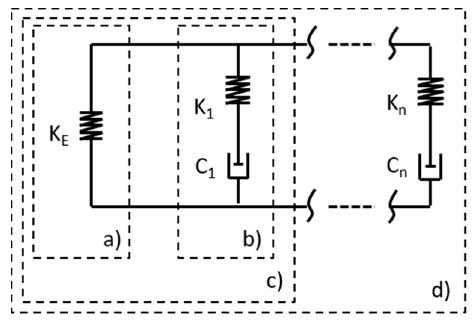
Figure 4 . Most common representations of viscoelastic material. ( a ) Ideal elastic material (Hooke’s representation); ( b ) Combination of restoring and damping force (Maxwell’s representation); ( c ) Kelvin’s representation; and, ( d ) Wiechert’s representation.